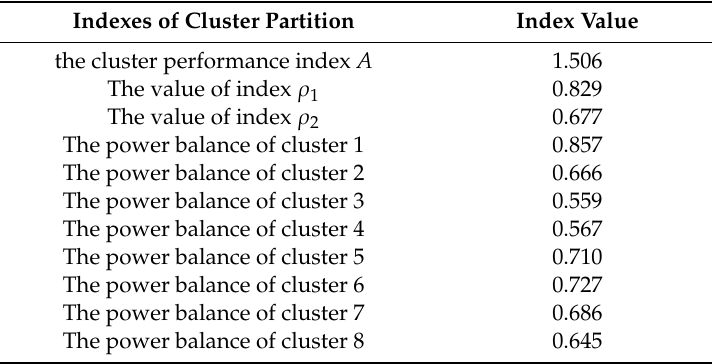
Table 2. The cluster partition indexes.